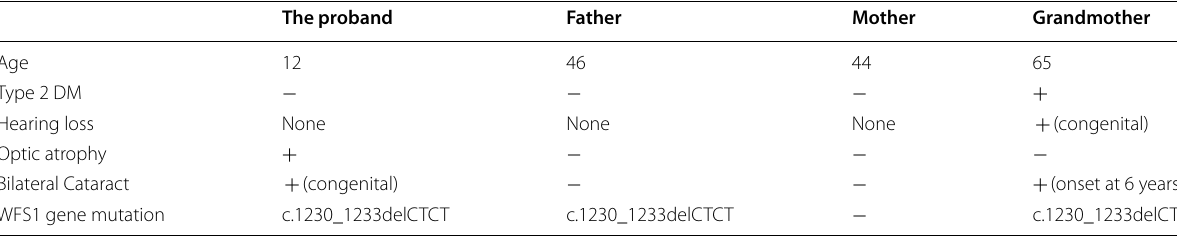
Table 1 Clinical characteristics of the proband’s